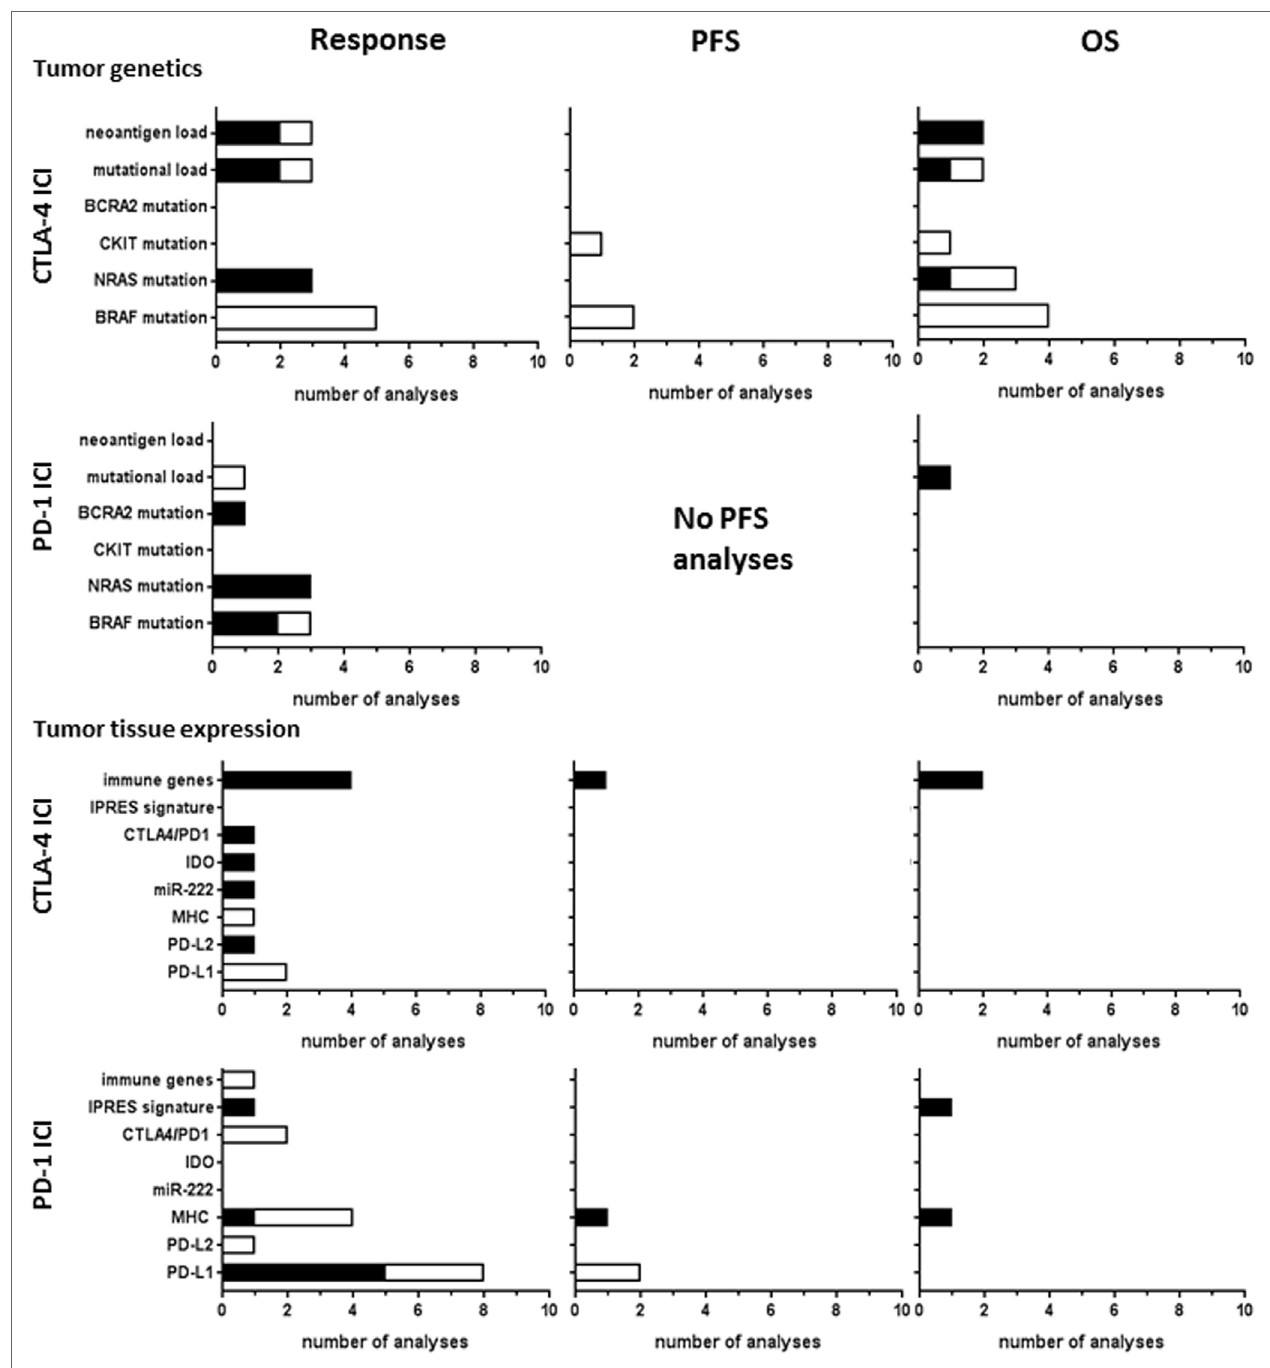
FiGURe 5 | Tumor tissue biomarkers analyzed for CTLA-4 or PD-1 immune checkpoint inhibitor (ICI). Graphs show the number of analyses per biomarker type for correlations with clinical response, progression-free survival (PFS), or overall survival (OS) upon CTLA-4 ICI therapy. Black bars, significant correlation; white bars, non-significant